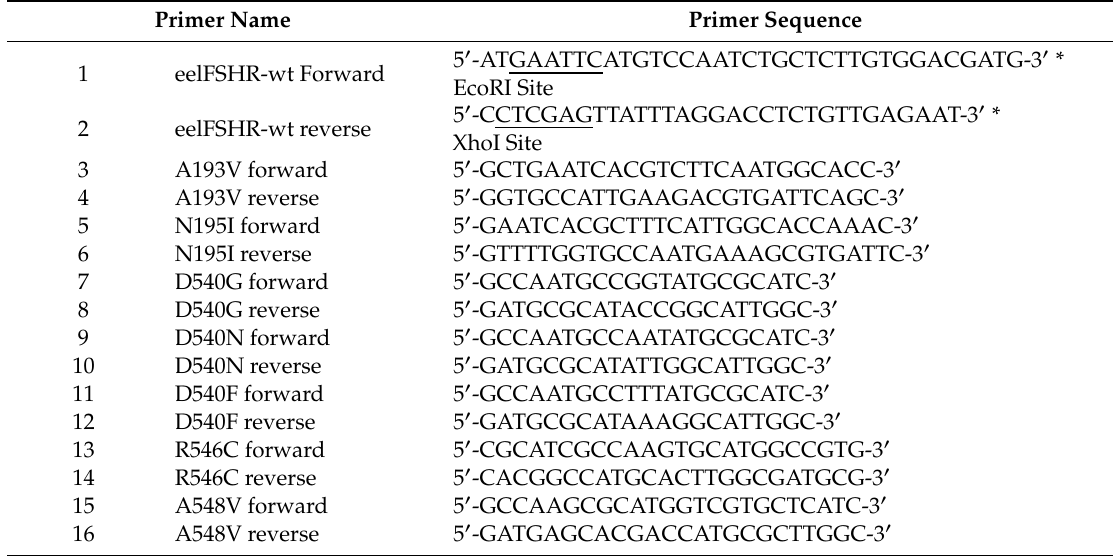
Table 4. List of primers used to construct the eelFSHR